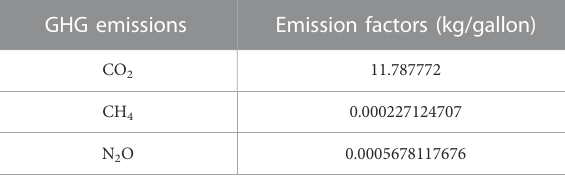
TABLE 6 GHG emission factors (EFs) for